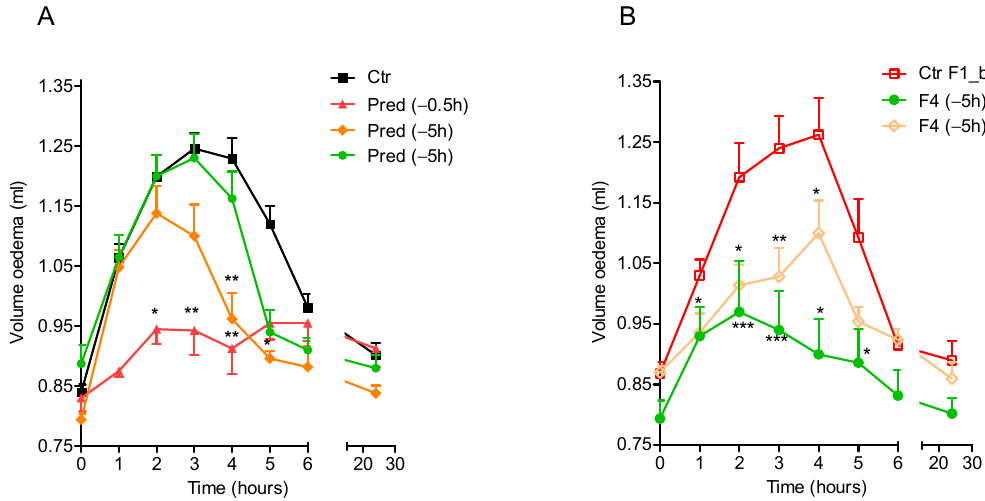
Figure 5. Oedema volume reduction obtained by administering per os pure prednisolone, Pred (Panel A), and #F4 (Panel B) at di ff erent time points (0.5, 5, or 15 h) to rats before carrageenan injection, compared with the control; mean ± SEM ( n = 4 animals per group). Panel A: black square → control group, Ctr, receiving as control 1 mL of methylcellulose (MC) 0.5% w / v; red triangle → group Pred ( − 0.5 h), receiving prednisolone half an hour before carrageenan injection; orange diamond → group Pred ( − 5 h), receiving prednisolone 5 h before carrageenan injection; green circle → group Pred ( − 15 h) receiving prednisolone 15 h before carrageenan injection. Panel B: empty red square → control group, Ctr F1_b, receiving as control blank beads; green circle → group F4 ( − 5 h), receiving #F4 5 h before carrageenan injection; empty pink diamond → group F4 ( − 15 h), receiving #F4 15 h before carrageenan injection. * p < 0.05, ** p < 0.01 compared to control.